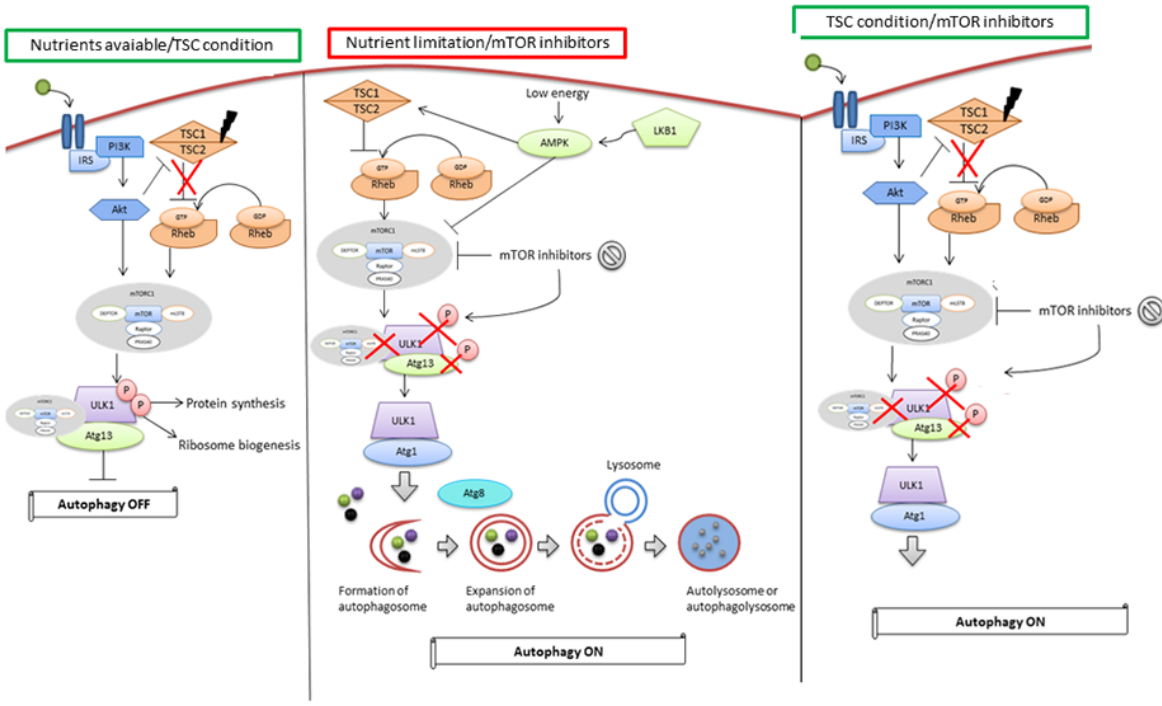
Figure 2 – Autophagy signaling with nutrients available or TSC condition and with nutrient limitation or presence of mTOR inhibitors. In this first scenario, the TSC complex is unable to prevent to conversion of Rheb-GDP to Rheb-GTP causing the activation of mTORC1. mTORC1 activated causes inactivation of ULK1 complex through the phosphorylation of ULK1 and ATG13, thus suppressing autophagy and allowed the protein synthesis and ribosome biogenesis. Conversely, in the second scenario, under nutrient limitations or with the presence of mTOR inhibitors, mTORC1 is inactivated, which enables the ULK1 complex to be activated together with Atg proteins which triggers the formation of doble membrane vesicule called autophagosomes around the cell content that need to be degraded. Autophagosome merges with lysosome forming autolysome or autophagolysosome that degrades this vesicule internal cell content. In parallel to autophagy induction, the inactivation of mTORC inhibits cell growth.